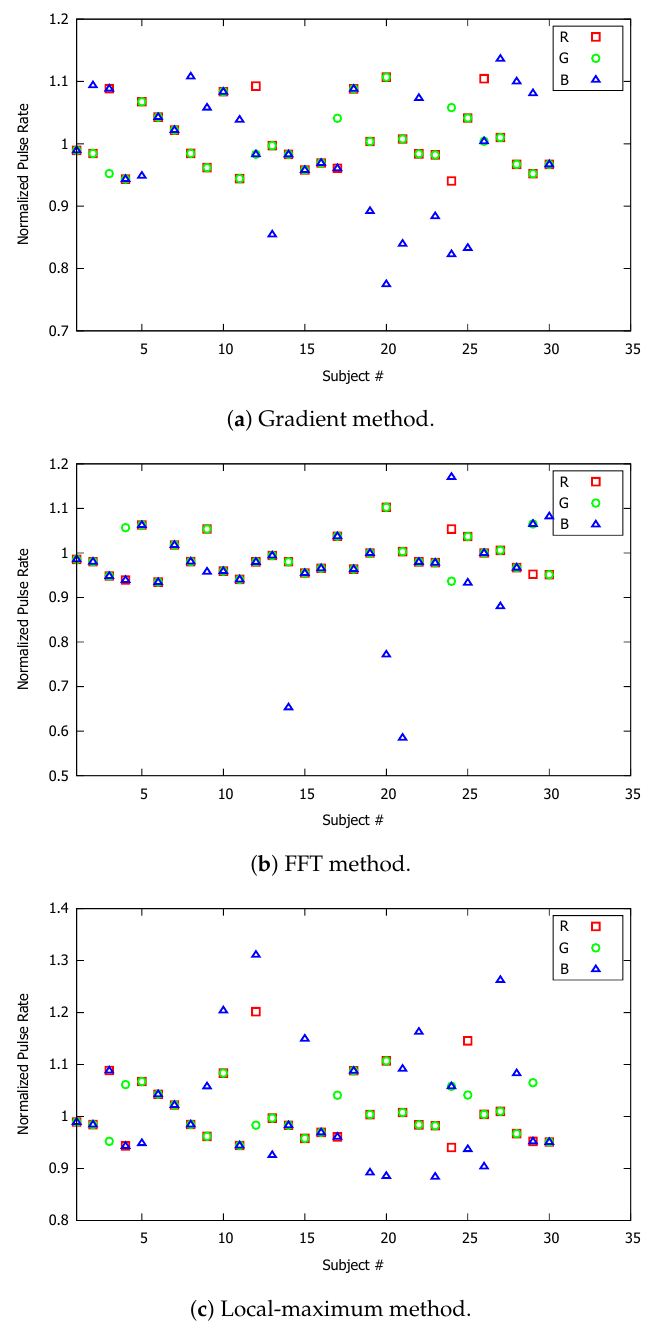
Figure 8. Normalized pulse rate (PR) of all participating volunteers; the video recording time in these graphs corresponds to 15